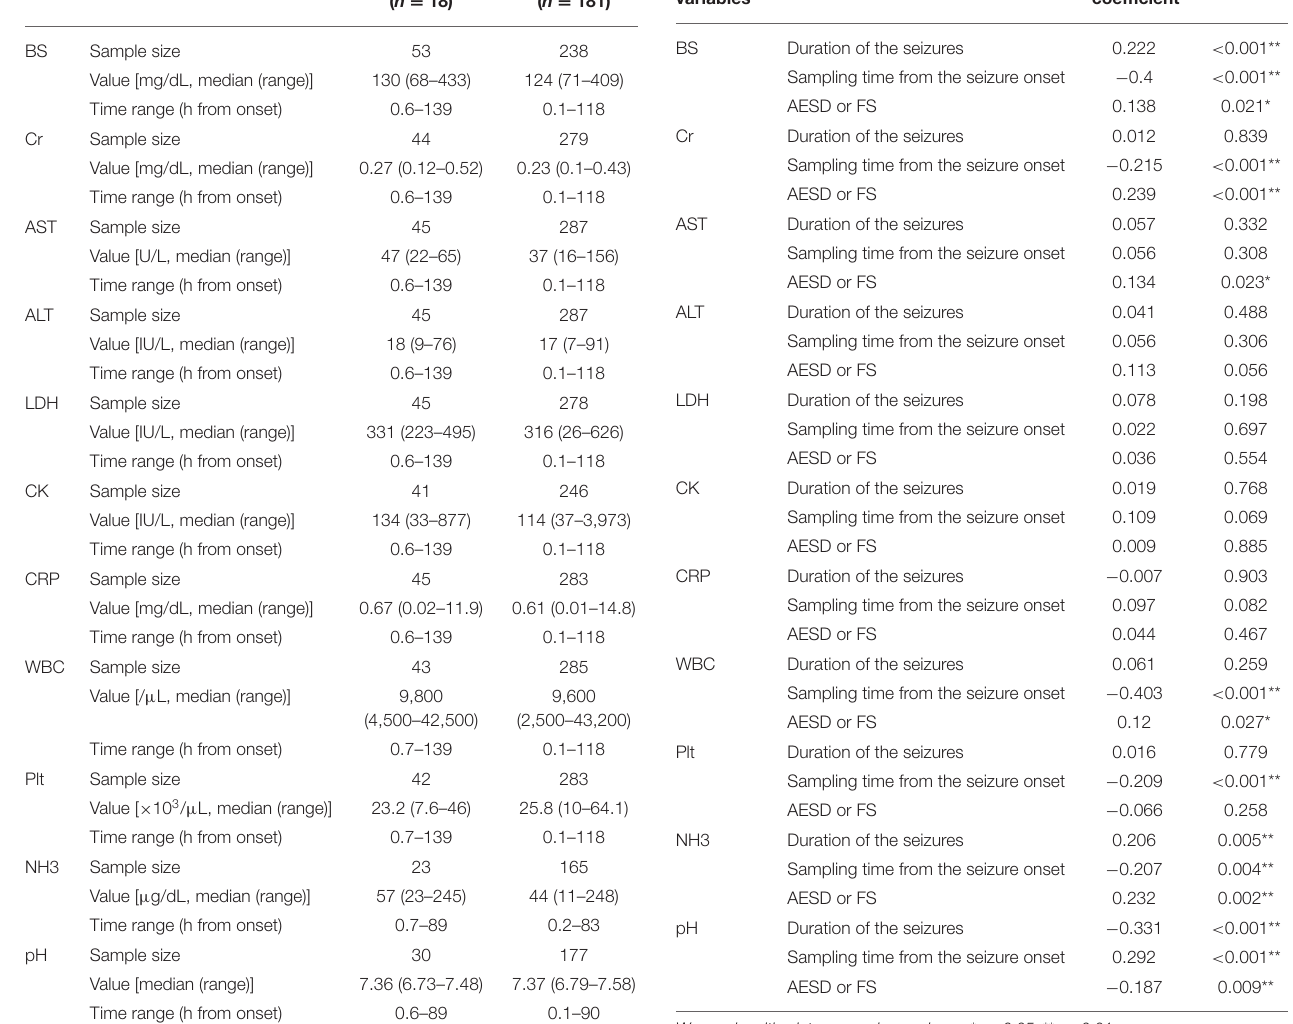
( Table 5 ). We derived the laboratory prediction score for AESD in patients with AESD and patients with FS for whom